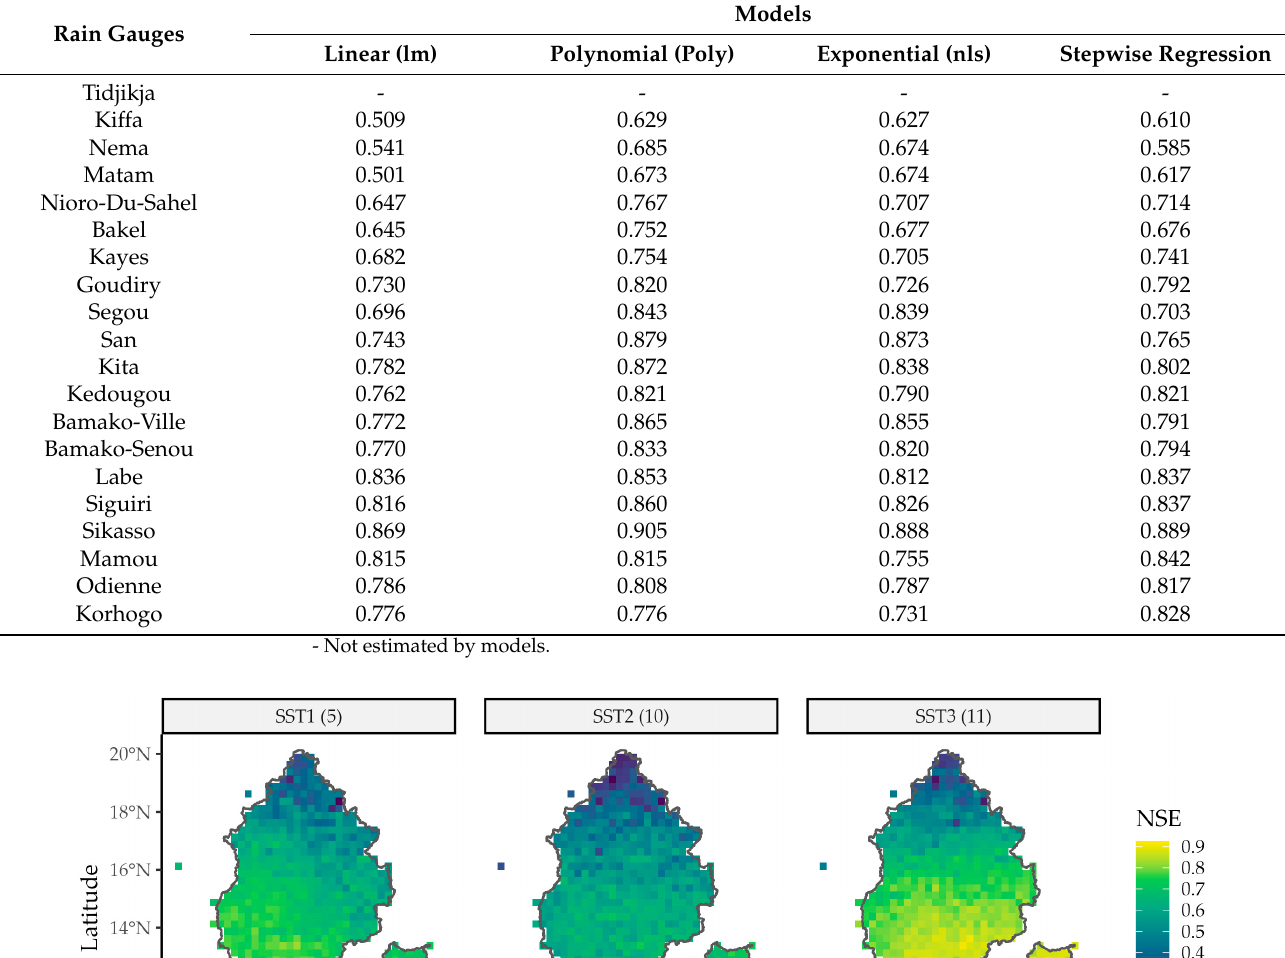
Table 3. Performance of precipitation forecast models, measured with NSE: linear, exponential, polynomial, and stepwise regression models at pixel-to-point.